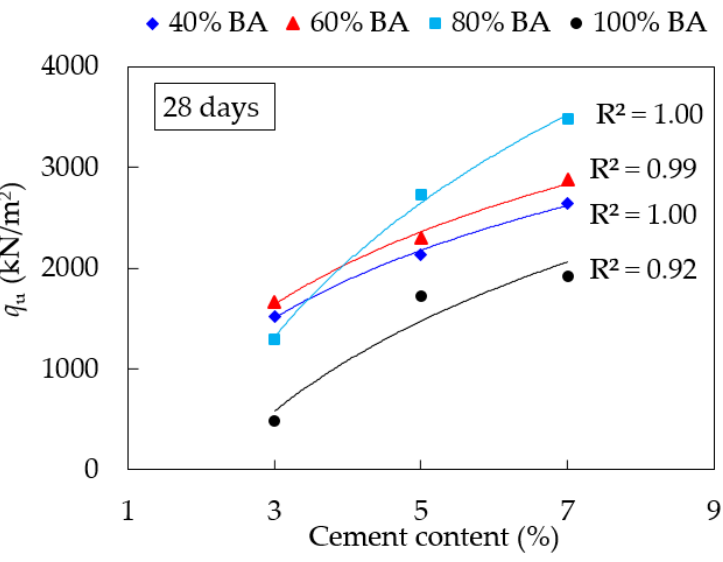
Figure 9. Relationship between q u and cement content at 28 days of curing time. The secant modulus ( E 50 ) obtained from the stress-strain curve was used to explain the stiffness of the CSS specimens. Figure 10 shows the relationship between the E 50 and q u values of the CSS specimens (i.e., 3, 5, and 7% cement contents) at 7, 14, and 28 days of the curing time. Regarding Figure 10, the E 50 increased linearly with an increase in the q u value, which was varied from 40 q u to 125 q u (i.e., red line in Figure 10) with the best fitting line of 84 q u and the R 2 of 0.872. It can be seen that the obtained E 50 - q u correlation from this study was consistent with the previous studies. For example, it was slightly lower than 106.82 q u for the cemented-lateritic soil in Malaysia which was presented by Wahab et al. [12]. Similar results were reported by Al-Jabban et al. [59] for the cement-treated sandy clayey silt in Sweden (i.e., 85 q u ) and Yin [60] for the cement-treated Hong Kong marine deposit (i.e., 89 q u ). Therefore, it is suggested that the relationship between E 50 and q u obtained from this study can be reliable in utilization in road pavement